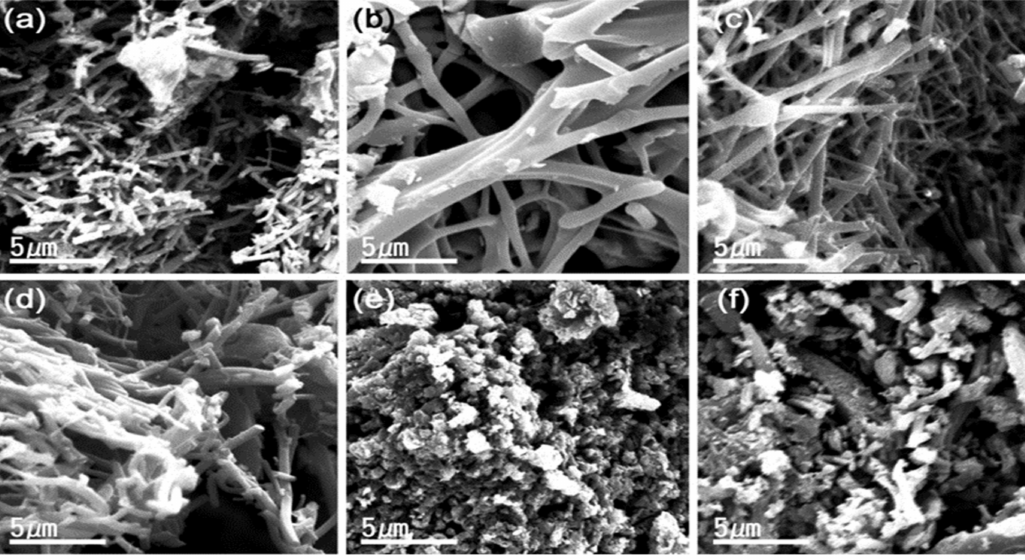
Figure 2. FE-SEM images of ( a ) T(G–Mn1)(550) NW, ( b ) T(G–Mn2)(550) NW, ( c ) T(G–Mn3)(550)